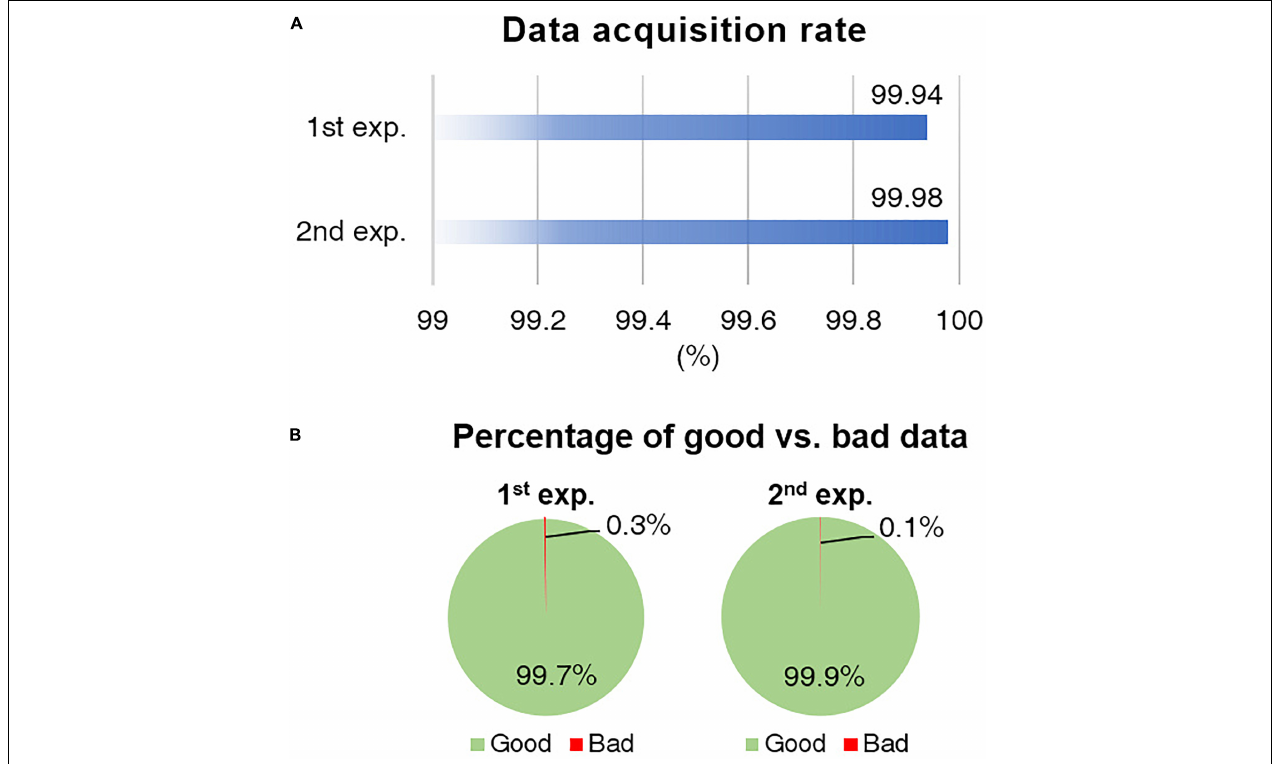
FIGURE 3 | (A) Data acquisition rate calculated through the comparison of internally saved and remotely retrieved data. (B) Percentage of good versus bad data in remotely retrieved